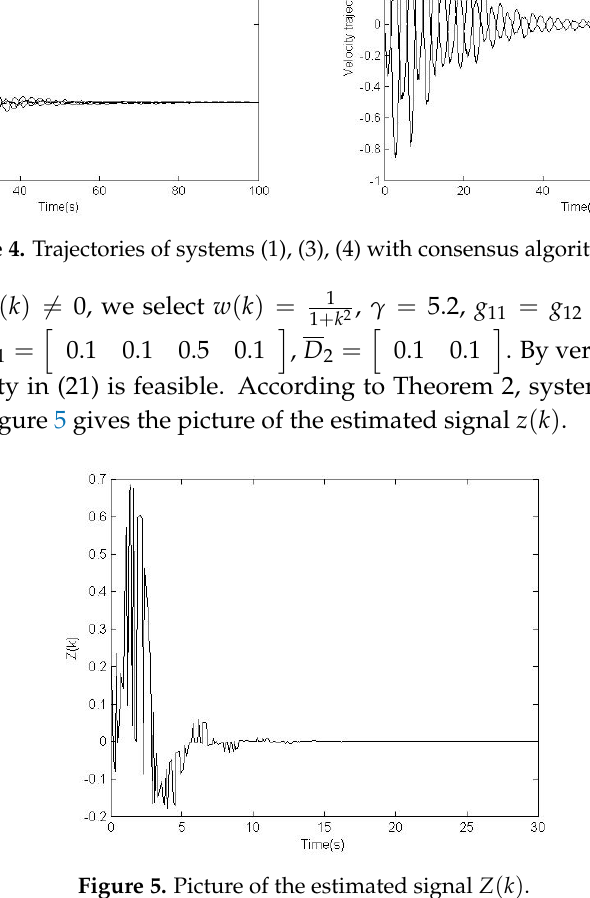
Figure 5. Picture of the estimated signal Z ( k )